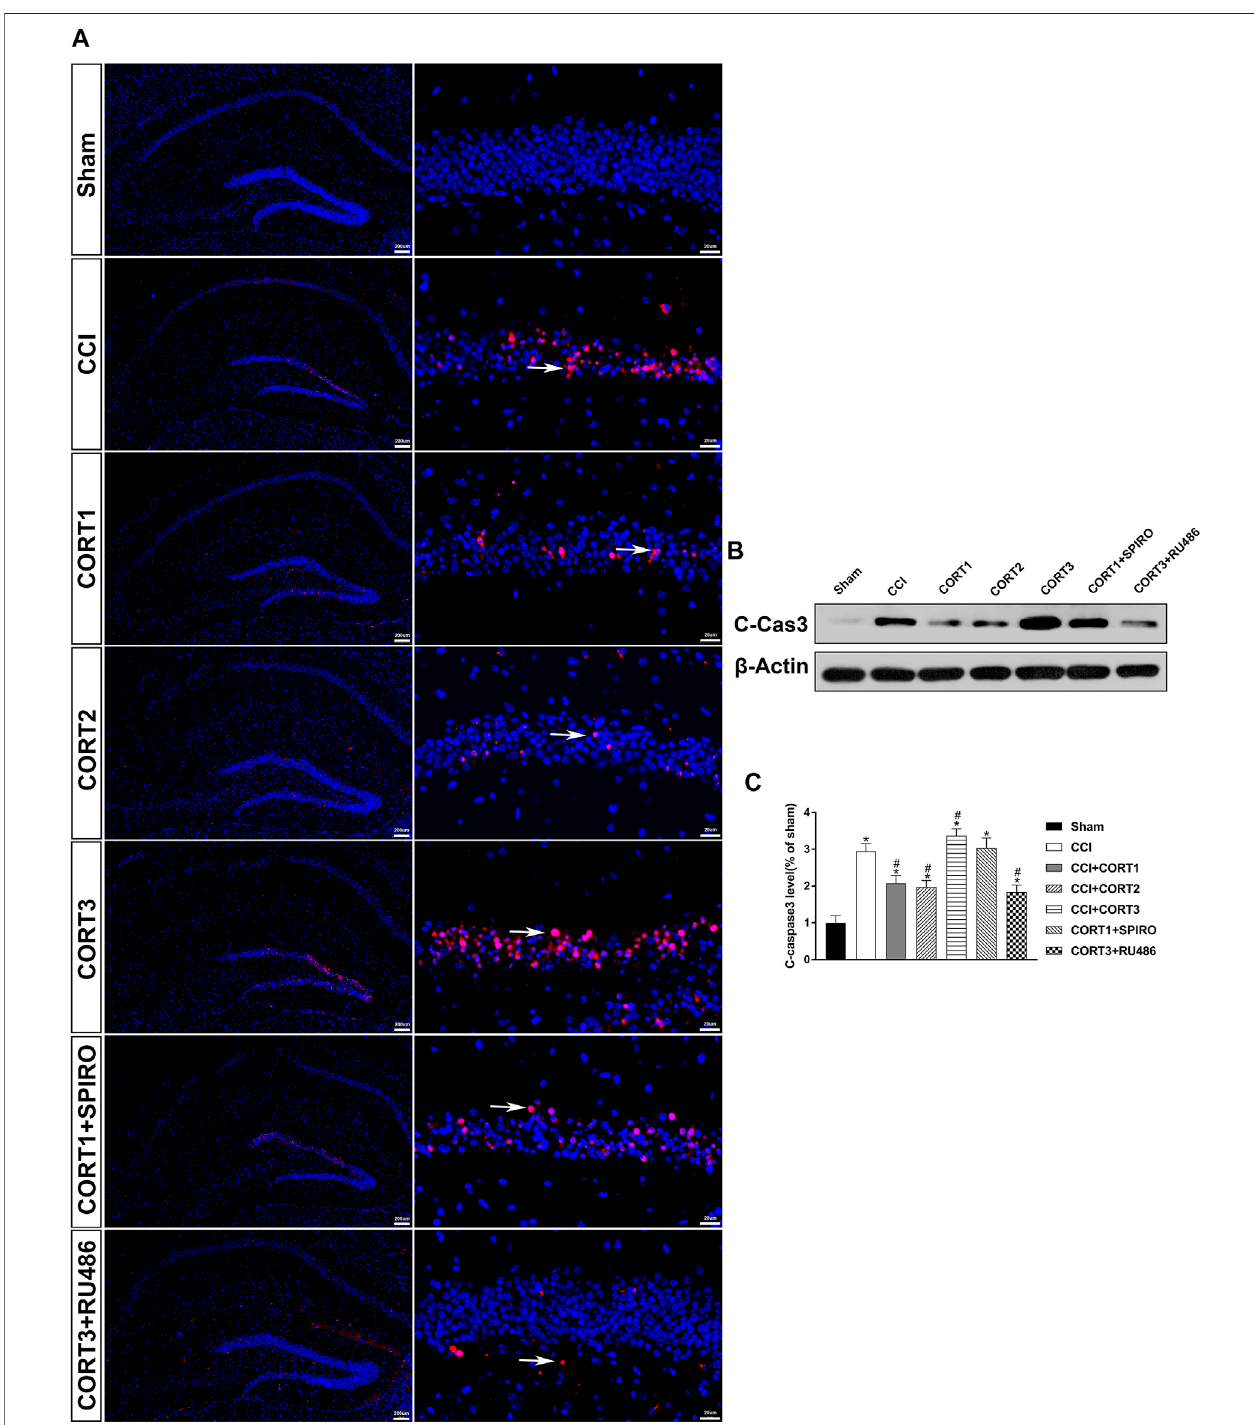
FIGURE 3| Dose-dependent effectsof CORT treatments on the level of cleaved caspase-3 after CCI. (A) Representative images ofcleaved caspase-3 (red, white arrow) immuno fl uorescence in the ipsilateral hippocampus. (B) Representative western blot images of cleaved caspase-3. (C) Quanti fi cation of cleaved caspase-3 expression.Therelativebanddensitywasmeasured withImageJsoftware(version1.49) andnormalized tothatof β -actin, andtheconcentration percentage compared to that of sham controls was calculated for each sample. * p < 0.05 compared to the sham group; # p ˂ 0.05 compared to the CCI control group. The data are presented as the means ± SDs of eight animals per group. Scale bar (cid:1) 200 μ M for the left column of Panel 3A and 20 μ M for the right column of Panel 3A.